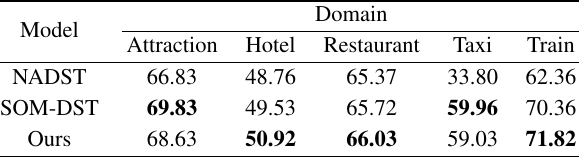
Table 4 Domain-specific accuracy on